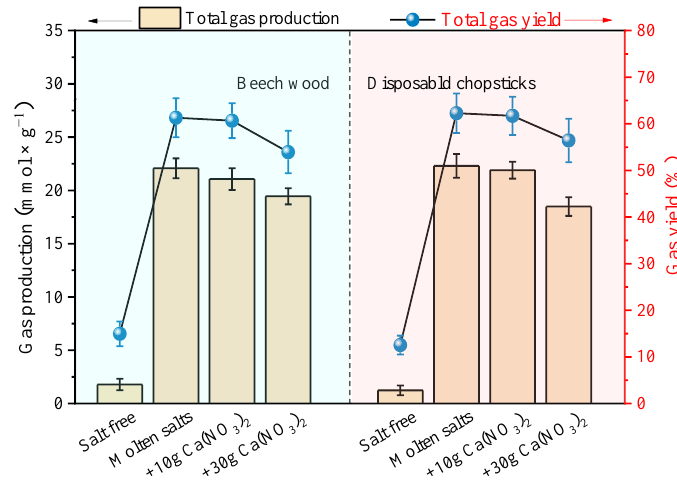
Figure 2. The generation properties of pyrolysis gases under different conditions.